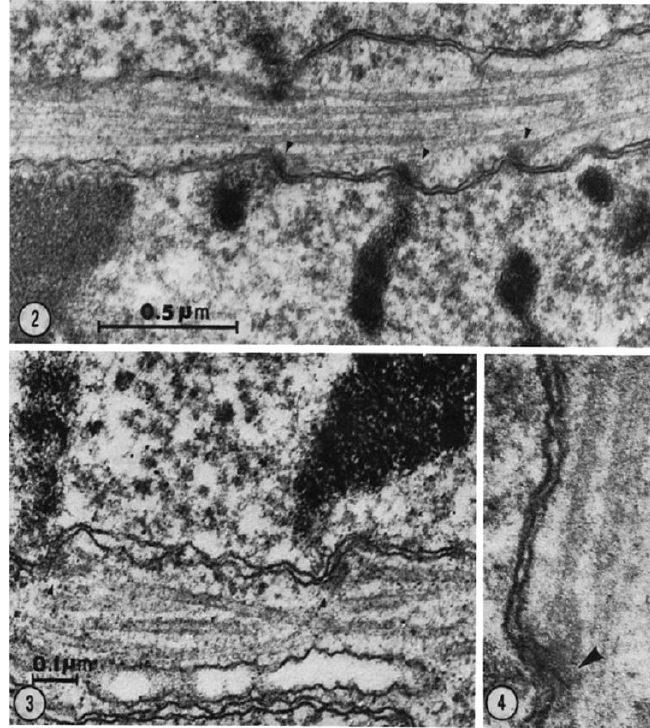
Figure 16. MTs, chromosomes and their interactions in the dinoflagellate, Amphidium . MTs run in a cytoplasmic channel, but some of them are connected to chromosomes through the nuclear envelope.